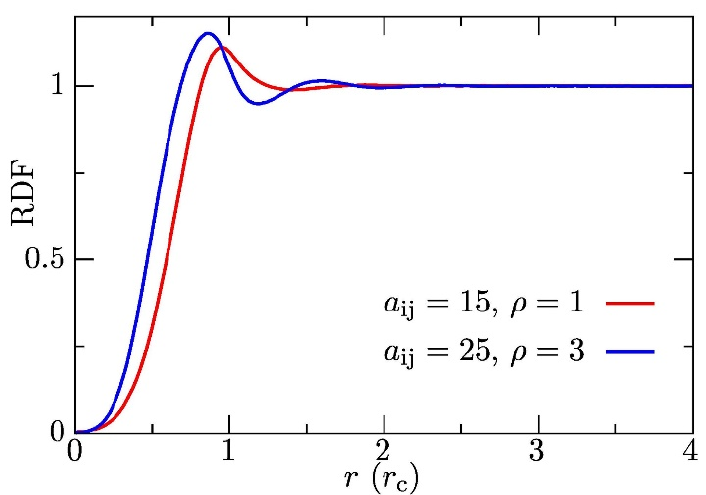
Figure 1. Radial distribution function for ρ = 3 (blue solid line) and ρ = 1 (red solid line).